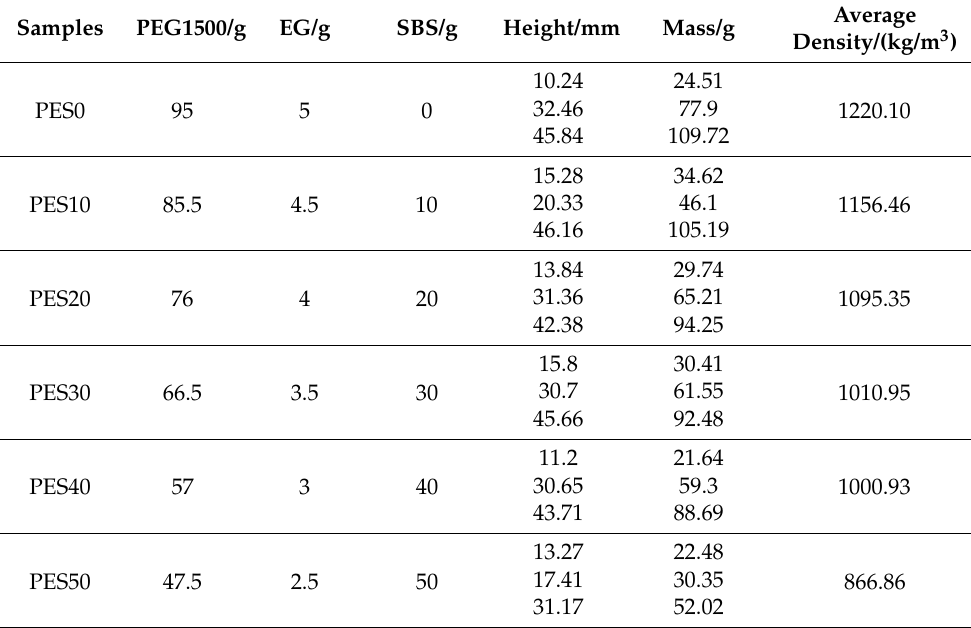
Table 1. The components and properties of flexible composite